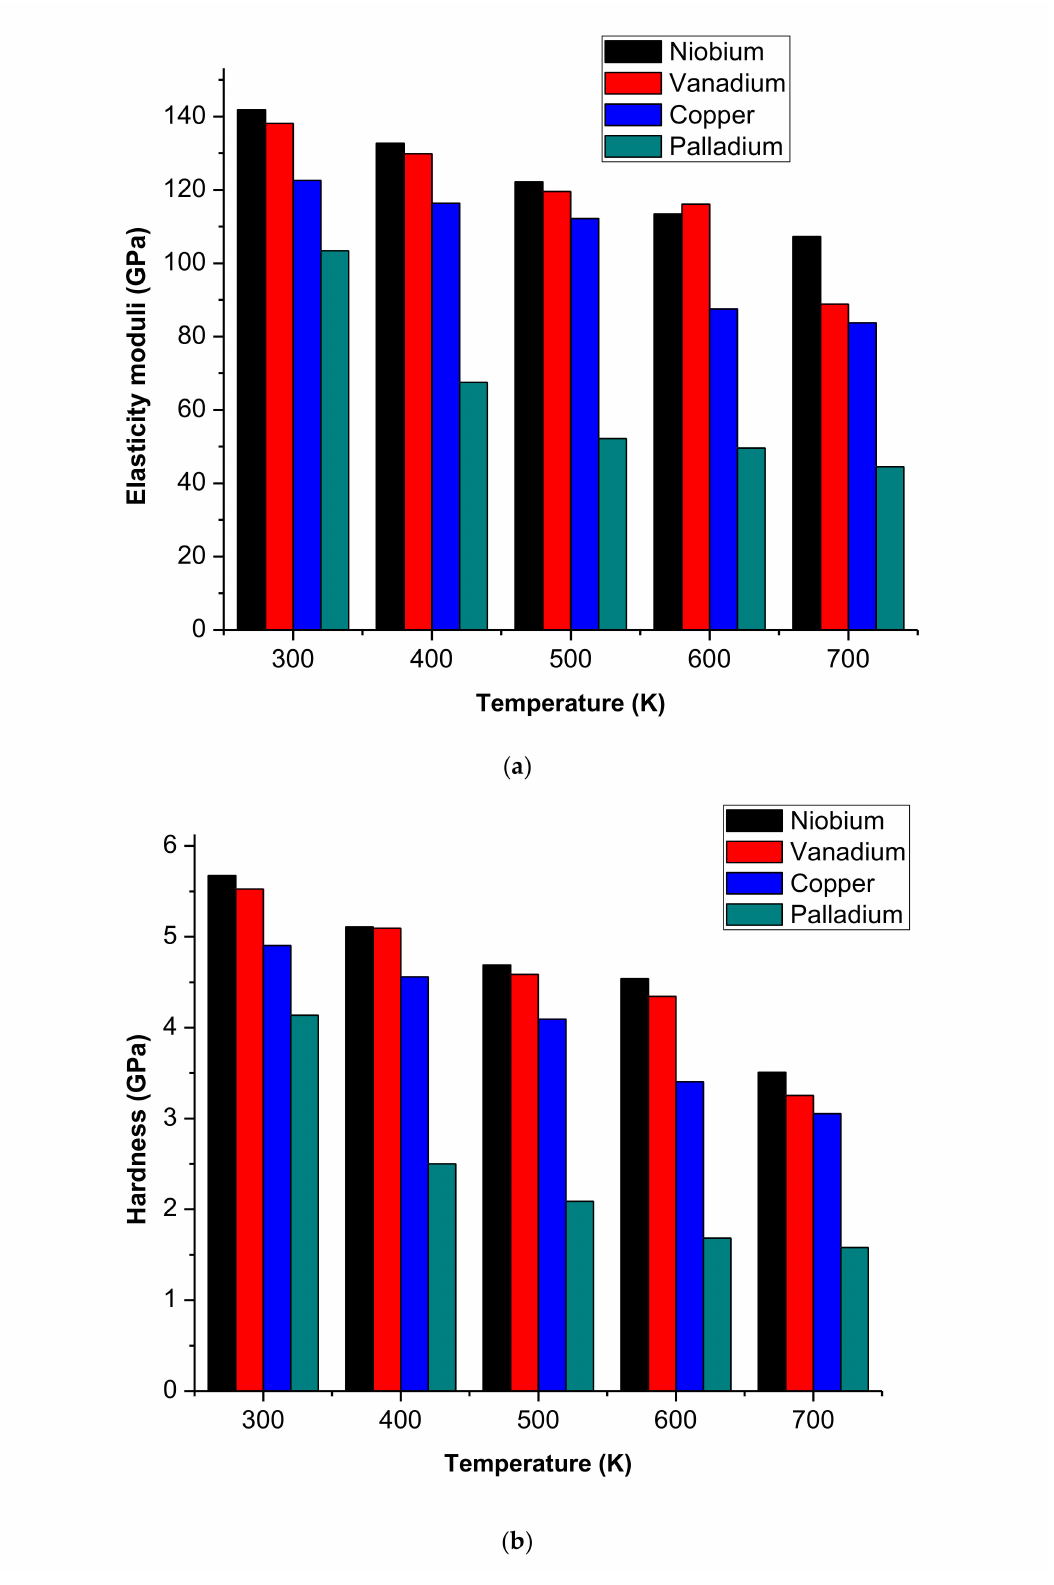
Figure 5. ( a ) The elasticity moduli versus temperature. ( b ) Hardness values versus temperature of the thin film coatings obtained from molecular dynamic (MD)